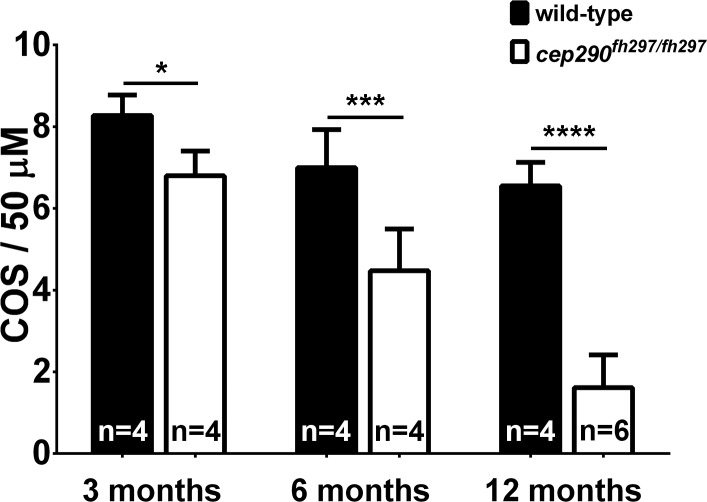
Cone outer segment density declines with age in cep290fh297/fh297 mutants.Quantification of cone outer segment density at ages from Fig 4. The number of independent fish used for each measurement is indicated. *P < 0.05; *** P < 0.0005; **** P < 0.0001 as determined by a 2-way ANOVA with a Multiple Comparisons test and Sidek corrections.